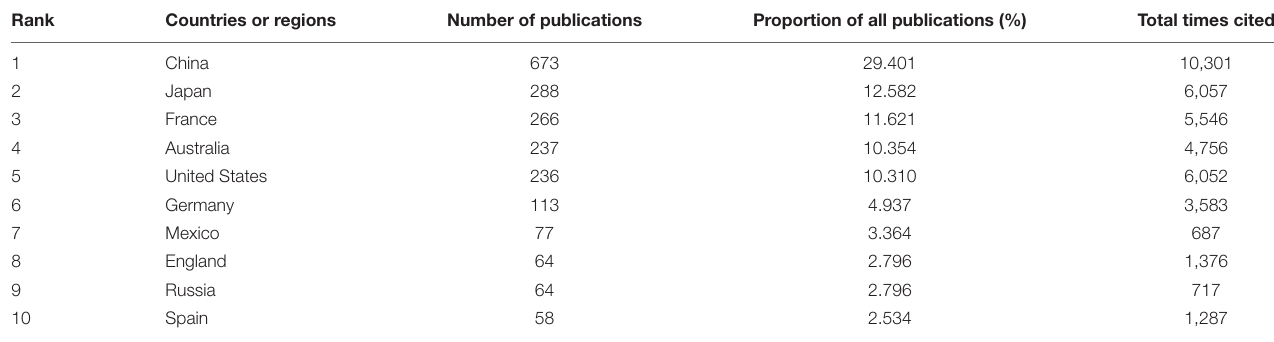
TABLE 2 | Among the studies related with pearl bivalve mollusks as the theme, the numbers of publications, the proportion of all publications, and the total times cited of the top 10 countries or regions ranked by the number of publications based on